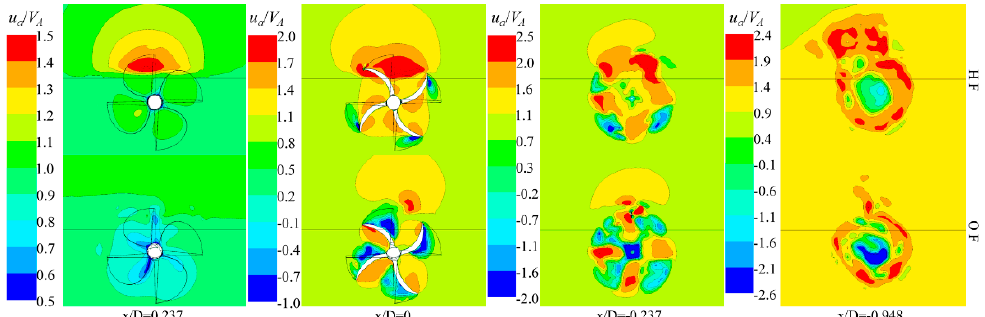
Figure 19. Comparison of axial velocity contours at different cutting planes.